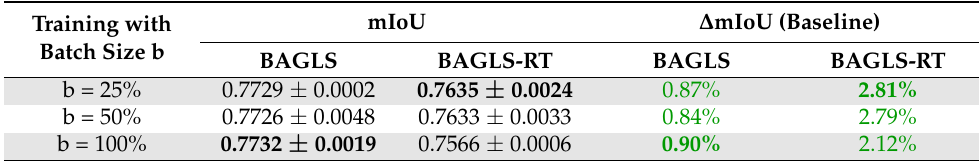
Table 4. Segmentation performance of the U-Net after incremental finetuning with knowledge distillation and the dynamic teacher model.